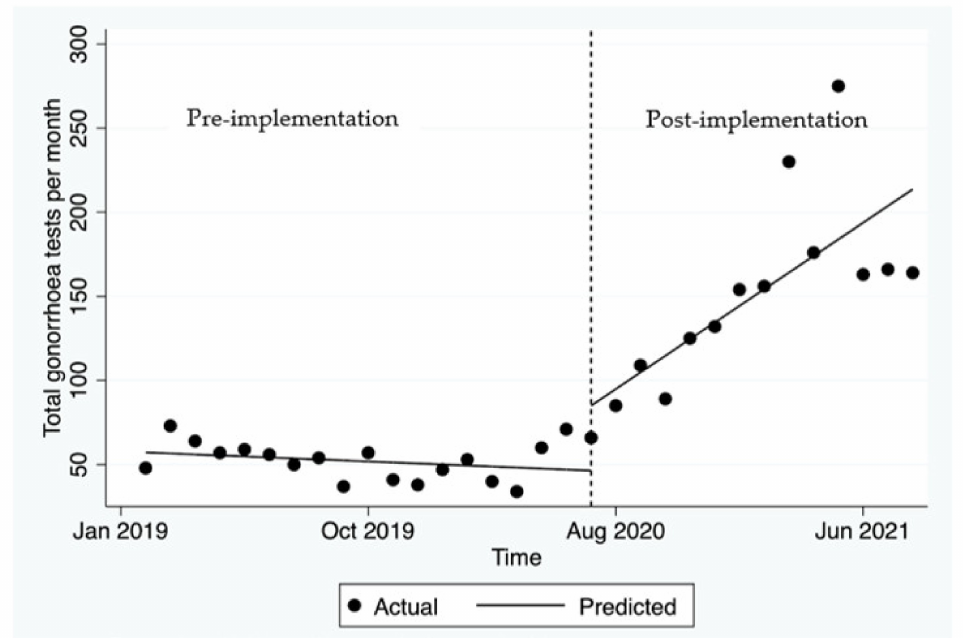
Figure 2. Number of tests for gonorrhoea before and after the hub-and-spoke model was launched.